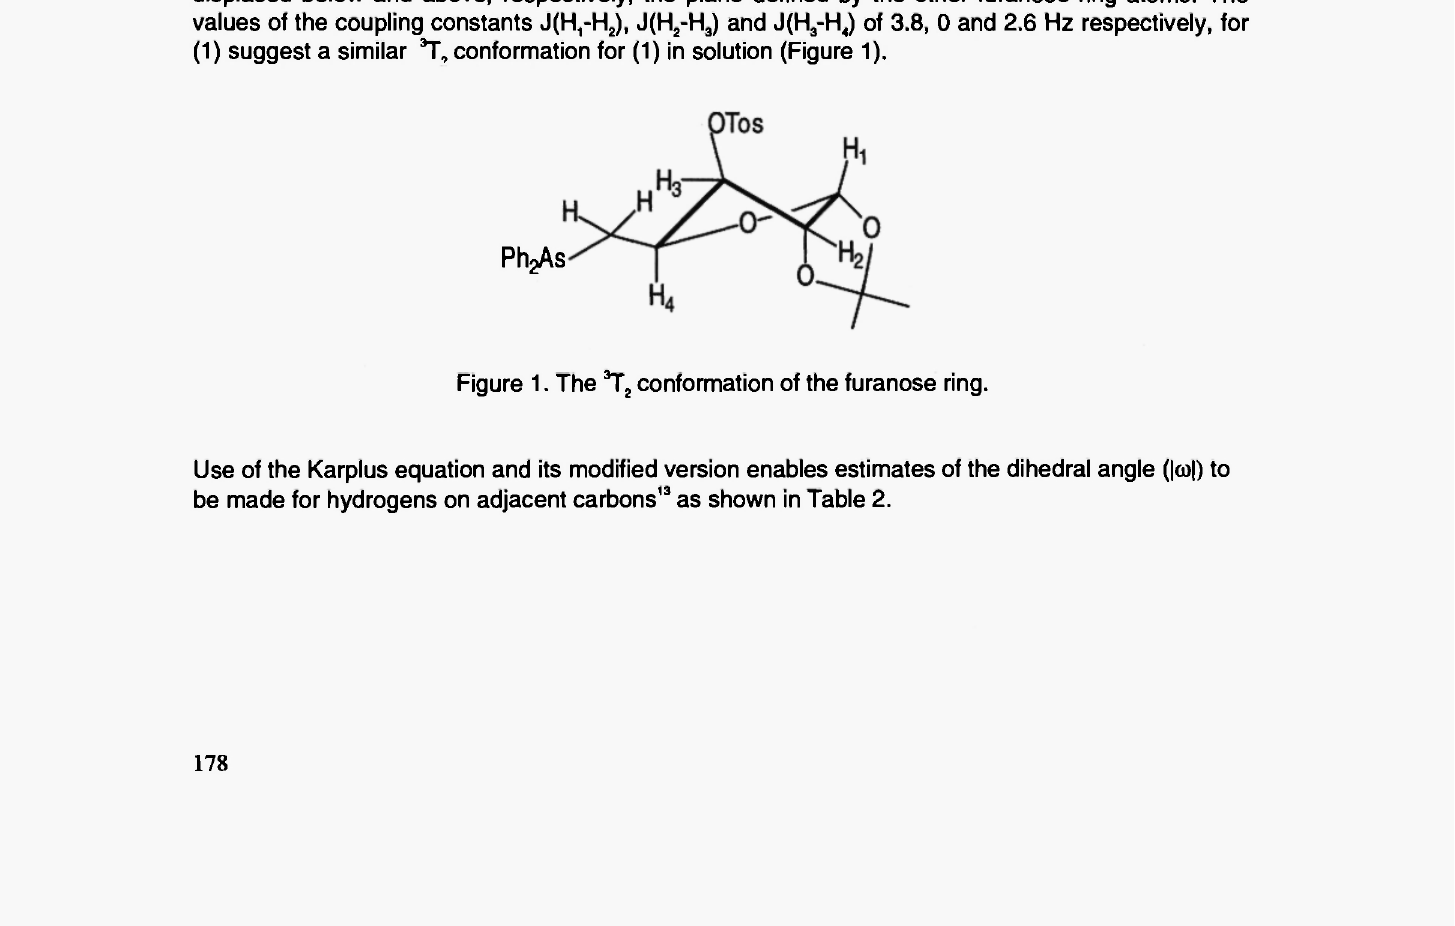
Figure 1. The % conformation of the furanose